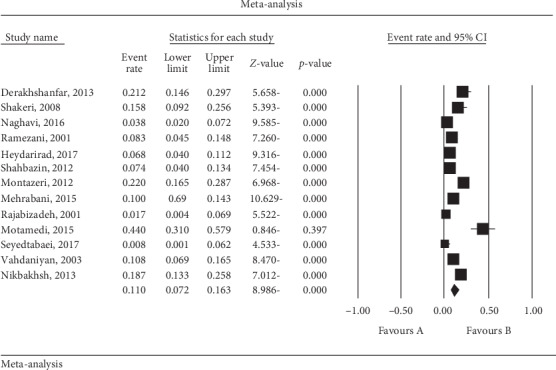
Forest plot of the included studies based on the random-effects model.